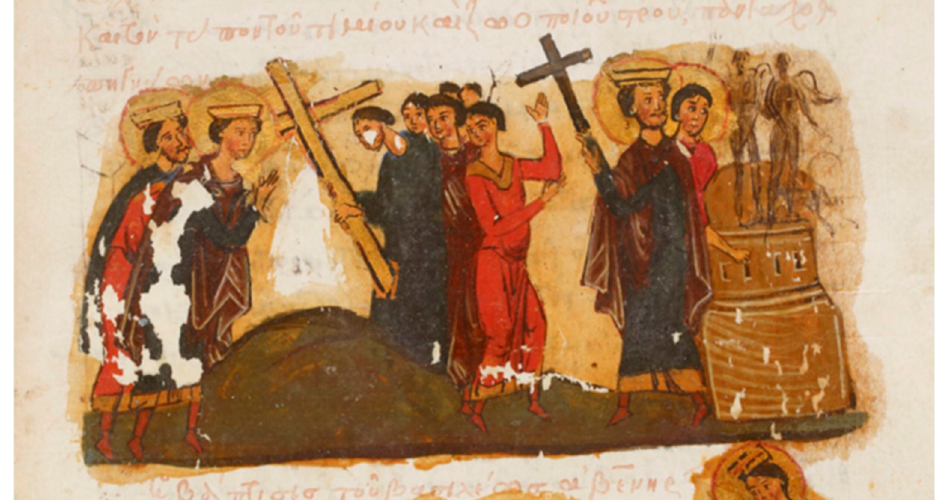
Figure 11. Paris. Bibliothèque nationale de France. Paris. gr. 1128, fol. 176r (detail). King Abenner destroys idols. Photo: gallica.bnf.fr/Bibliothèque nationale de France.